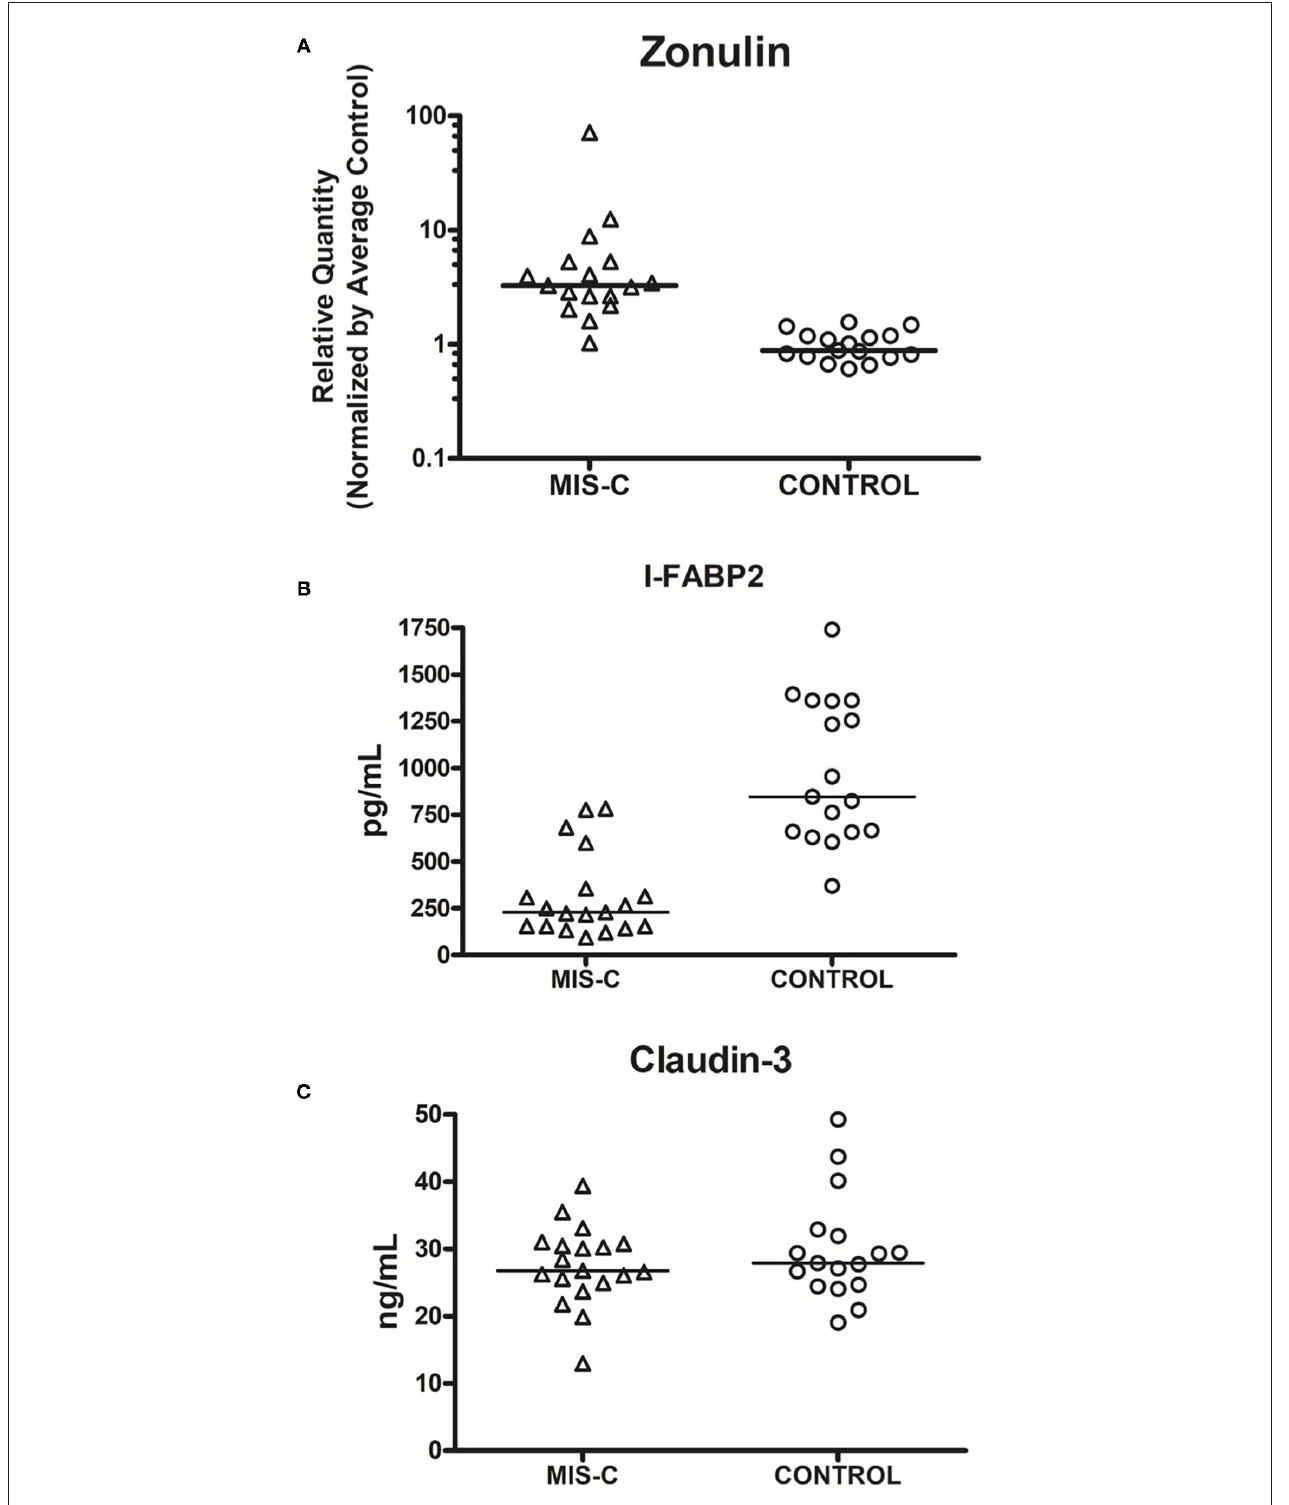
FIGURE 3 | Comparison of serum levels of markers of gut injury in cases vs. controls. (A) Zonulin ( P < 0.0001, Cases vs. Controls, Mann–Whitney Test). (B) I-FABP2 ( P < 0.0001, Cases vs. Controls, Mann–Whitney Test); (C) Claudin-3 ( P = 0.6573, Cases vs. Controls, Mann–Whitney Test). The line represents median. Each dot represents each sample that was